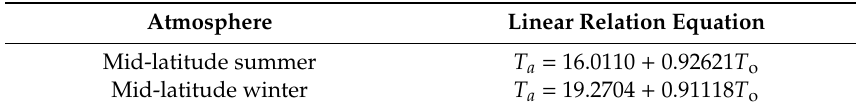
Table 4. The linear relations for approximation of e ff ective atmospheric temperature ( T a ) from the near-surface air temperature ( T o ) in the mid-latitude zone [18].